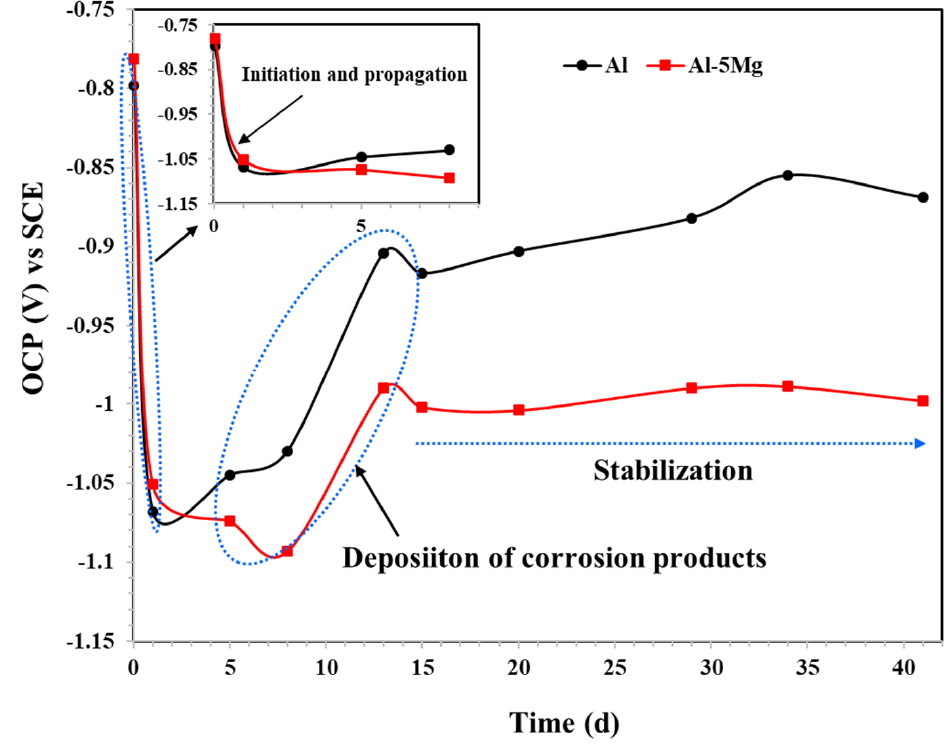
Figure 6. OCP of plasma arc thermal sprayed coating in 3.5 wt.% NaCl solution.